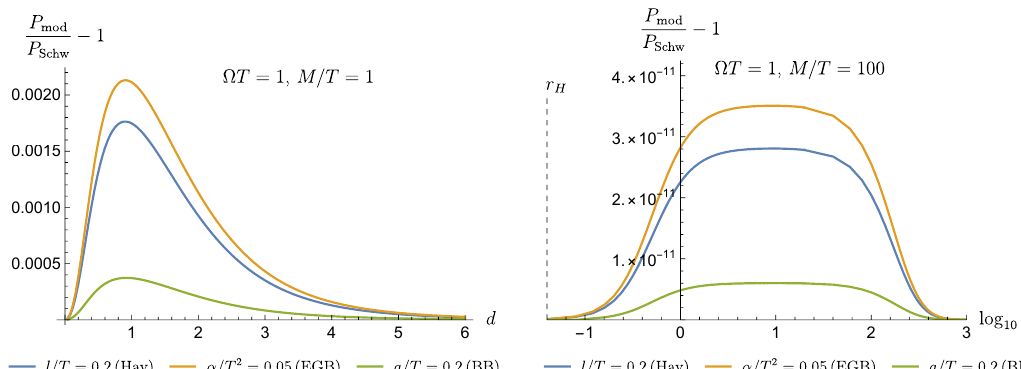
Figure 1 . The probability differences, computed as the ratio R = P mod /P Schw − 1 as a function of (dimensionless) proper distance d . We set Ω T = 1 and deformation parameter l/T = 0 . 2 for Hayward, α/T 2 = 0 . 05 for EGB and a/T = 0 . 2 for BB. (a) Small mass regime M/T = 1 . (b) Large mass regime M/T = 100 . In both cases we see that at intermediate distance away from the black hole the differences between the metrics are maximal, and the range of distances for which this is observable increases with